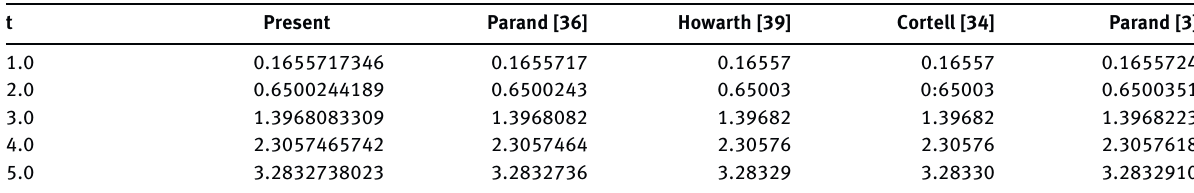
Table 11: Comparison of the obtained values of y ( t ) for various values of t by the present method, Parand et al. [3, 36], Howarth [39], and Cortell [34] t Present 1.0